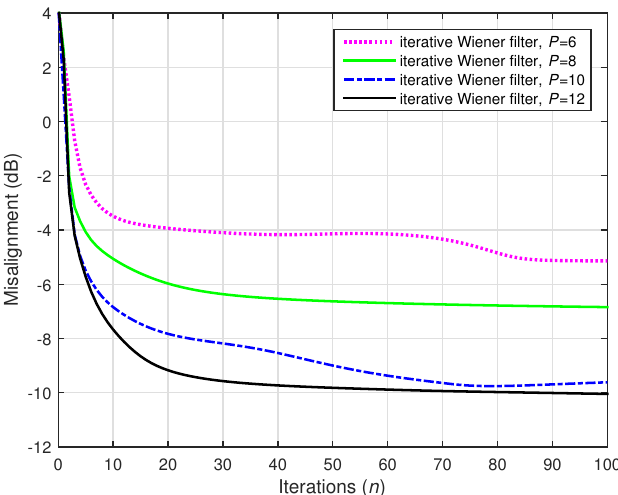
Figure 22. Performance of the iterative Wiener filter with different values of P , using N = 2000. The source signal (white Gaussian noise) was preprocessed with positive and negative half-wave rectifiers, using α = 0.5. The numbers of channels were M = 2 (stereophonic scenario), L = 1024, and SNR = 30